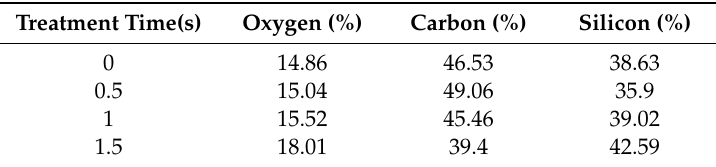
Table 1. XPS results from the treatment of Ecoflex 00-50.